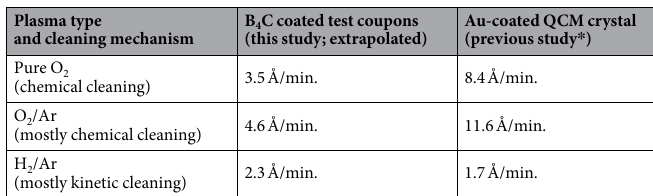
Table 6. Experimentally derived a-C cleaning rates for different types of plasma feedstock gases for either B 4 C- coated Si test wafers and Au-coated QCM crystals. All values were measured using 100 W plasma RF power at a plasma vacuum pressure of 0.005 mbar ( * data taken from refs 7,8